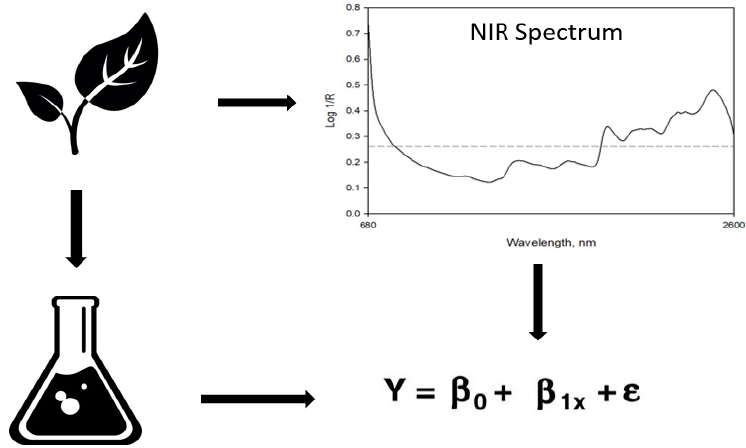
Figure 1. Illustration of the procedure used for applying near infrared spectroscopy (NIRS) technique in forage quality predictions.